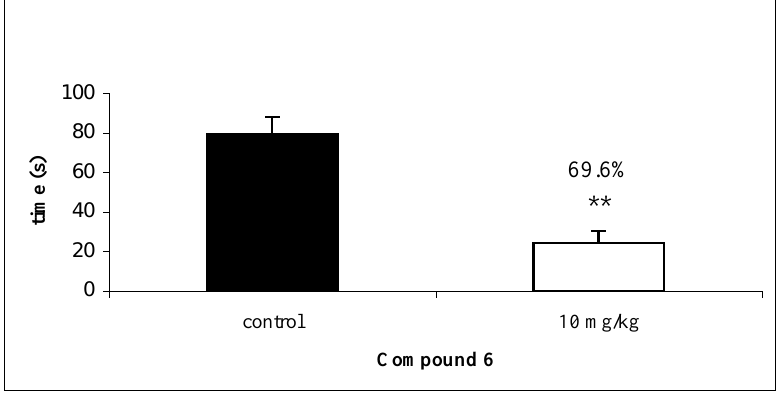
Figure 3. Effect of compound 6 (10 mg/kg), on licking/biting response induced by intraplantary injection of capsaicin in mice. Each group represents the mean of six to eight experiments. ** p < 0.01, compared with the corresponding control